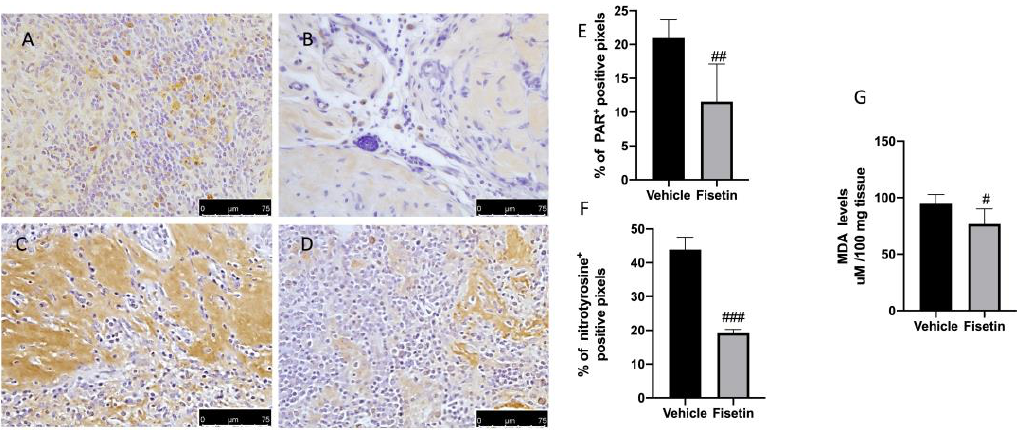
Figure 4. Fisetin administration on oxidative stress: Immunohistochemistry for PAR and nitrotyrosine in endometriosis + vehicle ( A , C ), in endometriosis + fisetin ( B , D ). The results are expressed as % of positive pixels ( E , F ). Figures are representative of at least three independent experiments. MDA levels ( G ). Values are means ± SEM of 6 animals for each group. Scale bar: 75 μm. ### p < 0.001 vs. vehicle. # p < 0.05 vs. vehicle. ## p < 0.01 vs. vehicle.